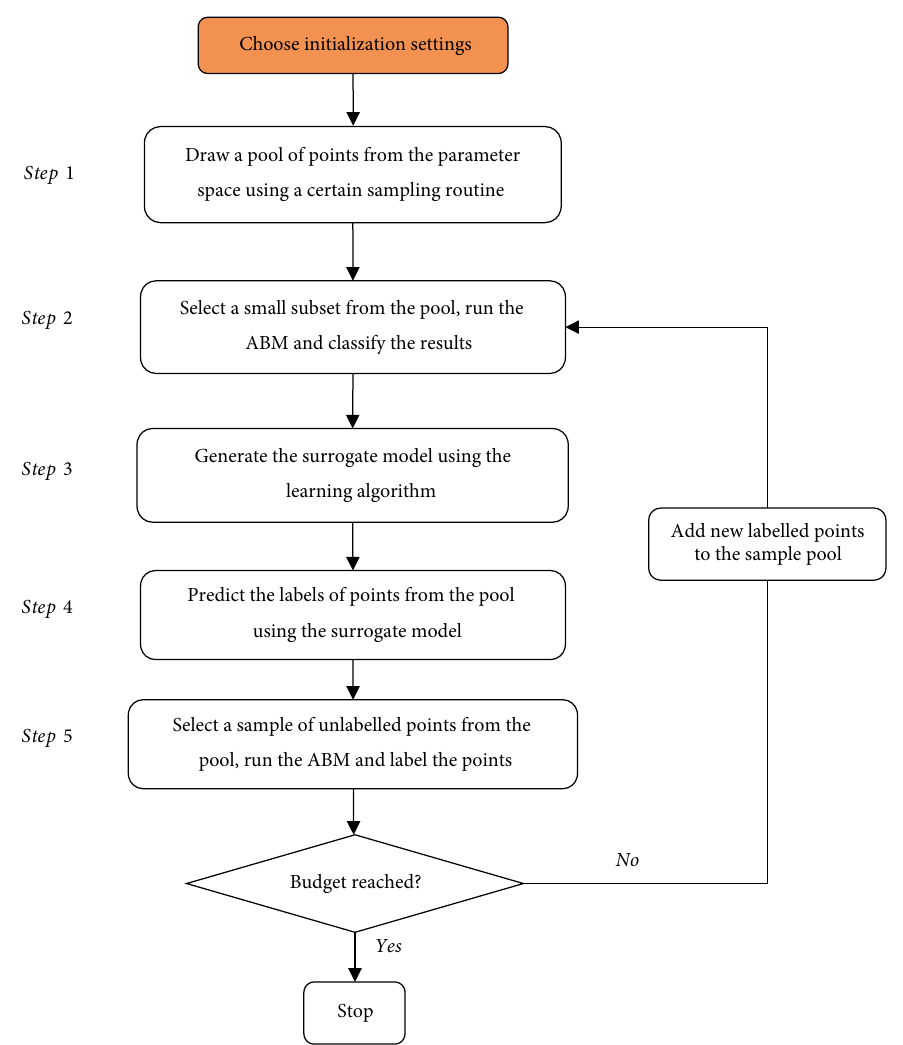
Figure 1: The surrogate model generation